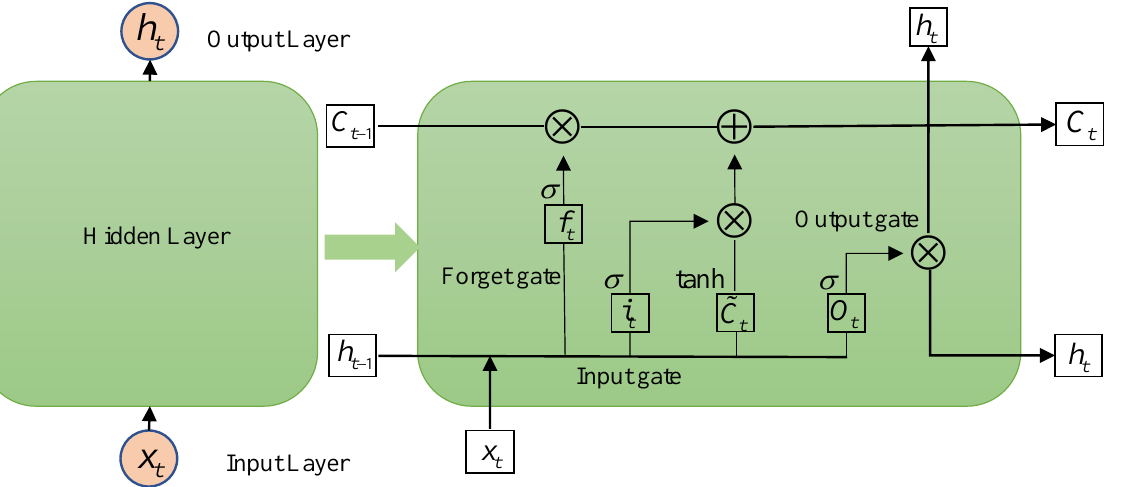
Figure 3. LSTM neural network memory unit structure.